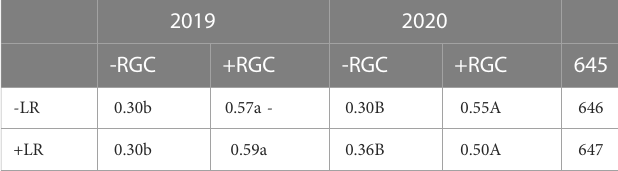
TABLE 2 The re fl ected red to far-red ratio (R:FR) measured at the cluster zone as affected by using (+) or without using (-) light-re fl ective ground cover